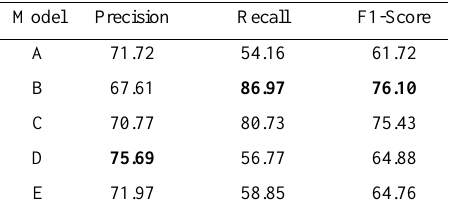
Table 6. Models performance on test set